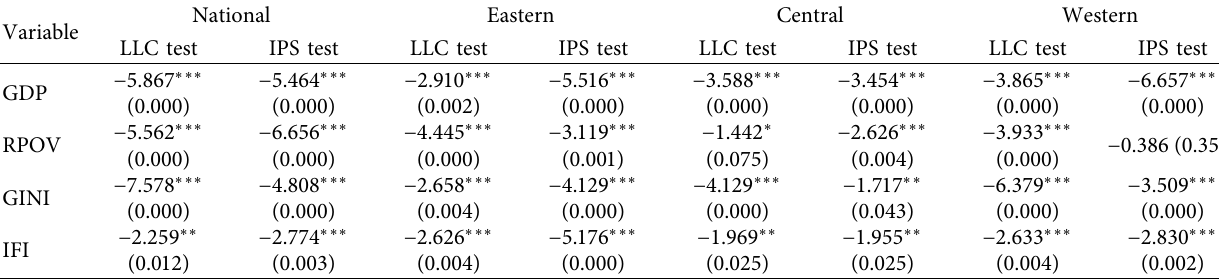
Table 2: Unit root test of variables.